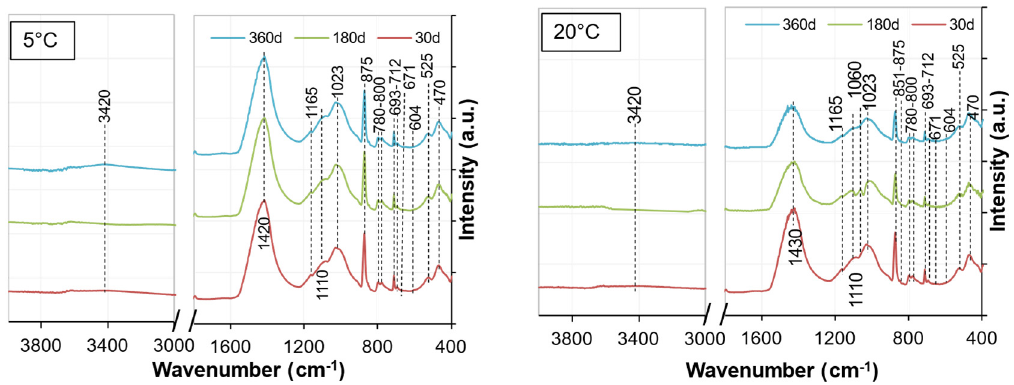
Figure A10. FTIR results of S + F + W3. Figure A9. FTIR results of S + F + W1.